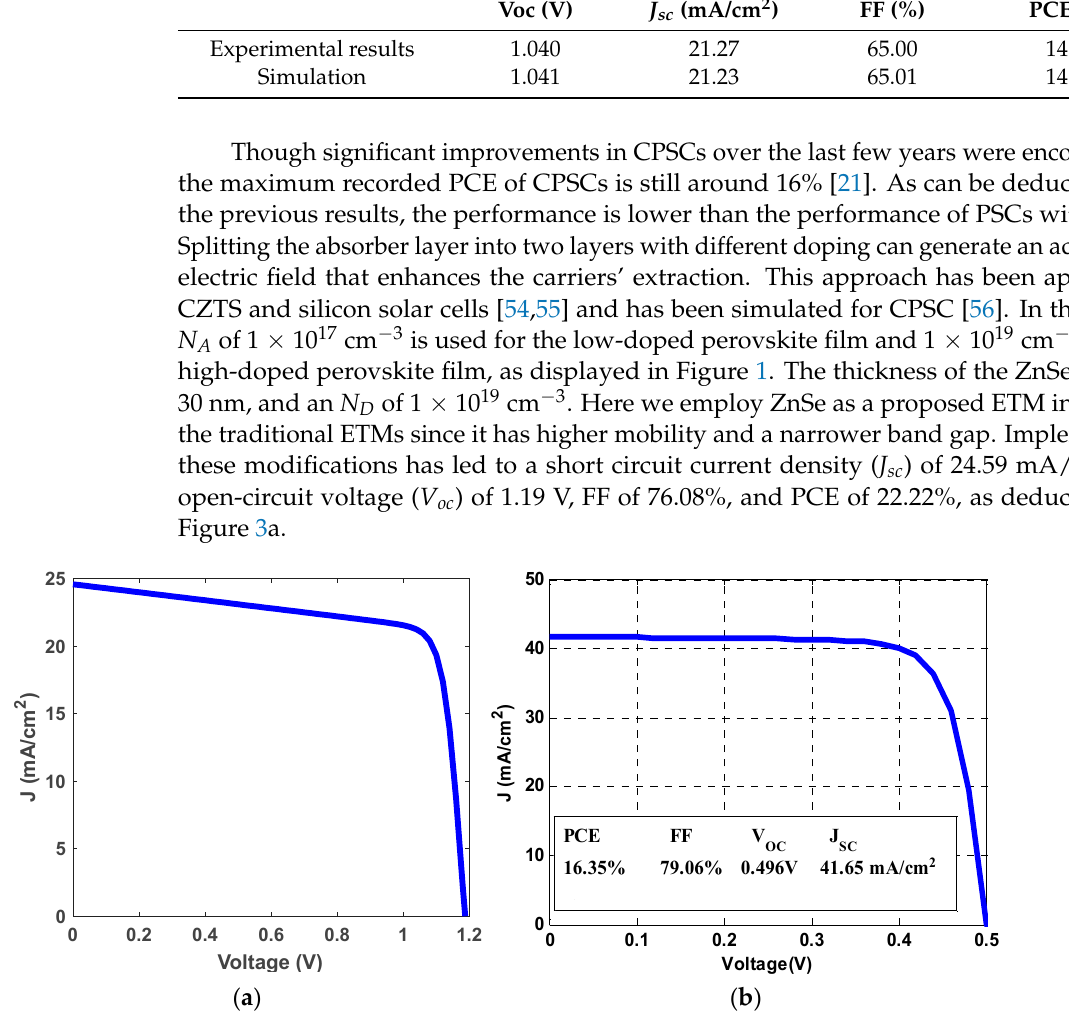
Figure 3. JV curves of ( a ) the modified CPSC, and ( b ) the Si solar cell and its outputs.